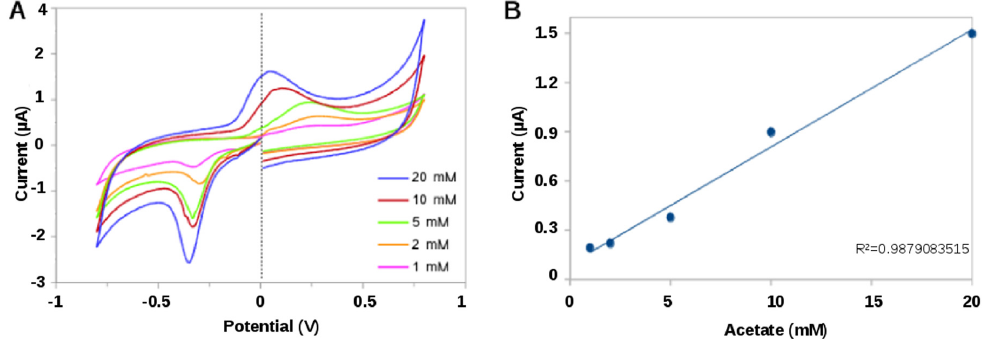
Figure 5. ( A ) Voltammograms corresponding to SPE ‐ monolayer of G. sulfurreducens exposed to solutions with different acetate concentration; ( B ) Calibration curve for acetate concentration between 1 mM and 20 mM, calculated from current display at 0 V according to the CV.